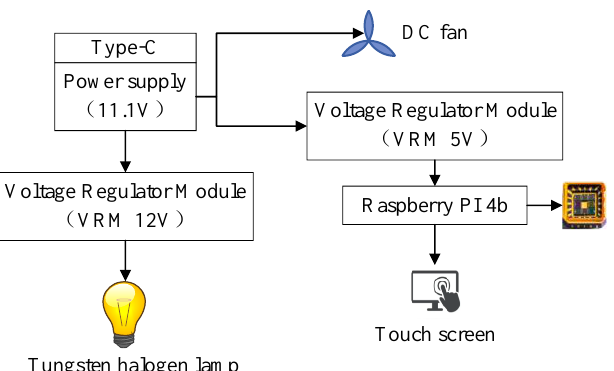
Figure 3. Structure diagram of the power supply unit.